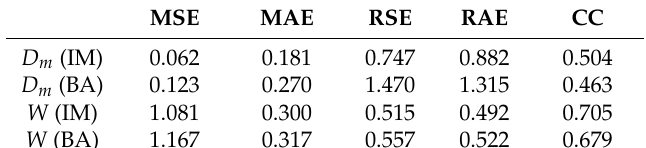
Table 4. Same as Table 3, but for real radar data.